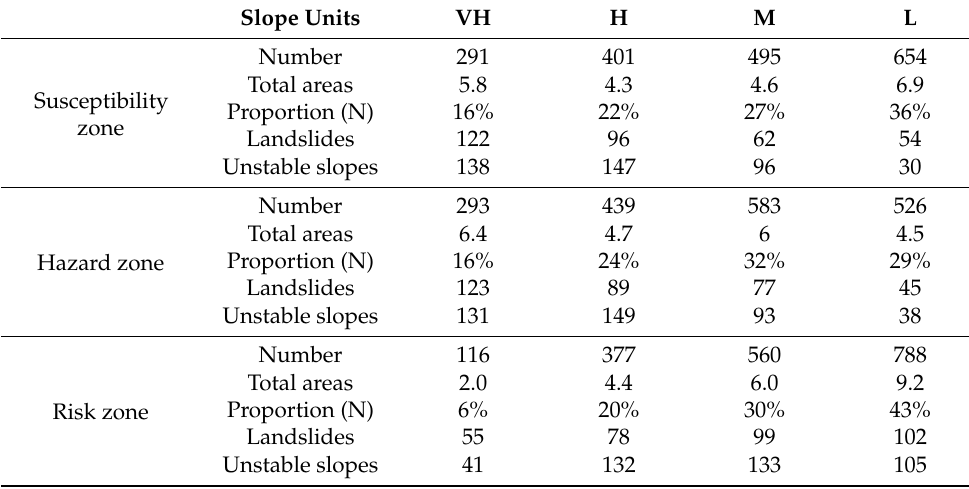
Figure 10. Landslide susceptibility map of the study area in ( a ), and the distribution of the landslide susceptibility index using the natural breaks in ( b ). Table 5. Slope unit statistics based on landslide susceptibility, hazard, and risk zone.